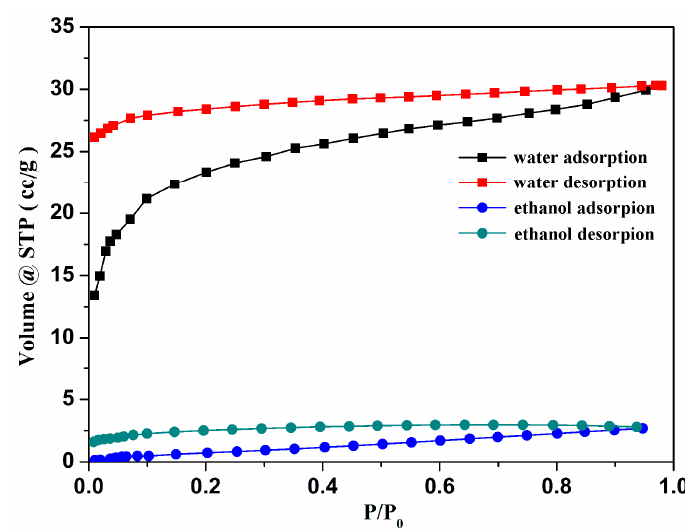
Figure 7. Water (squares) and ethanol (circles) vapor adsorption isotherms of JUC-112 at 298 K.